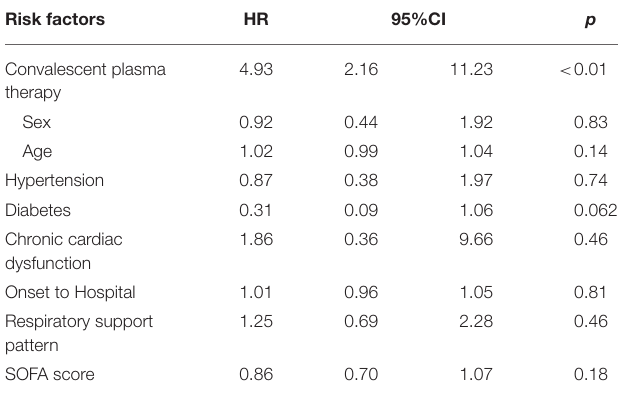
TABLE 5 | Competing risk analysis to explore convalescent plasma therapy associated with events of interest in severe and life-threatening coronavirus disease 2019